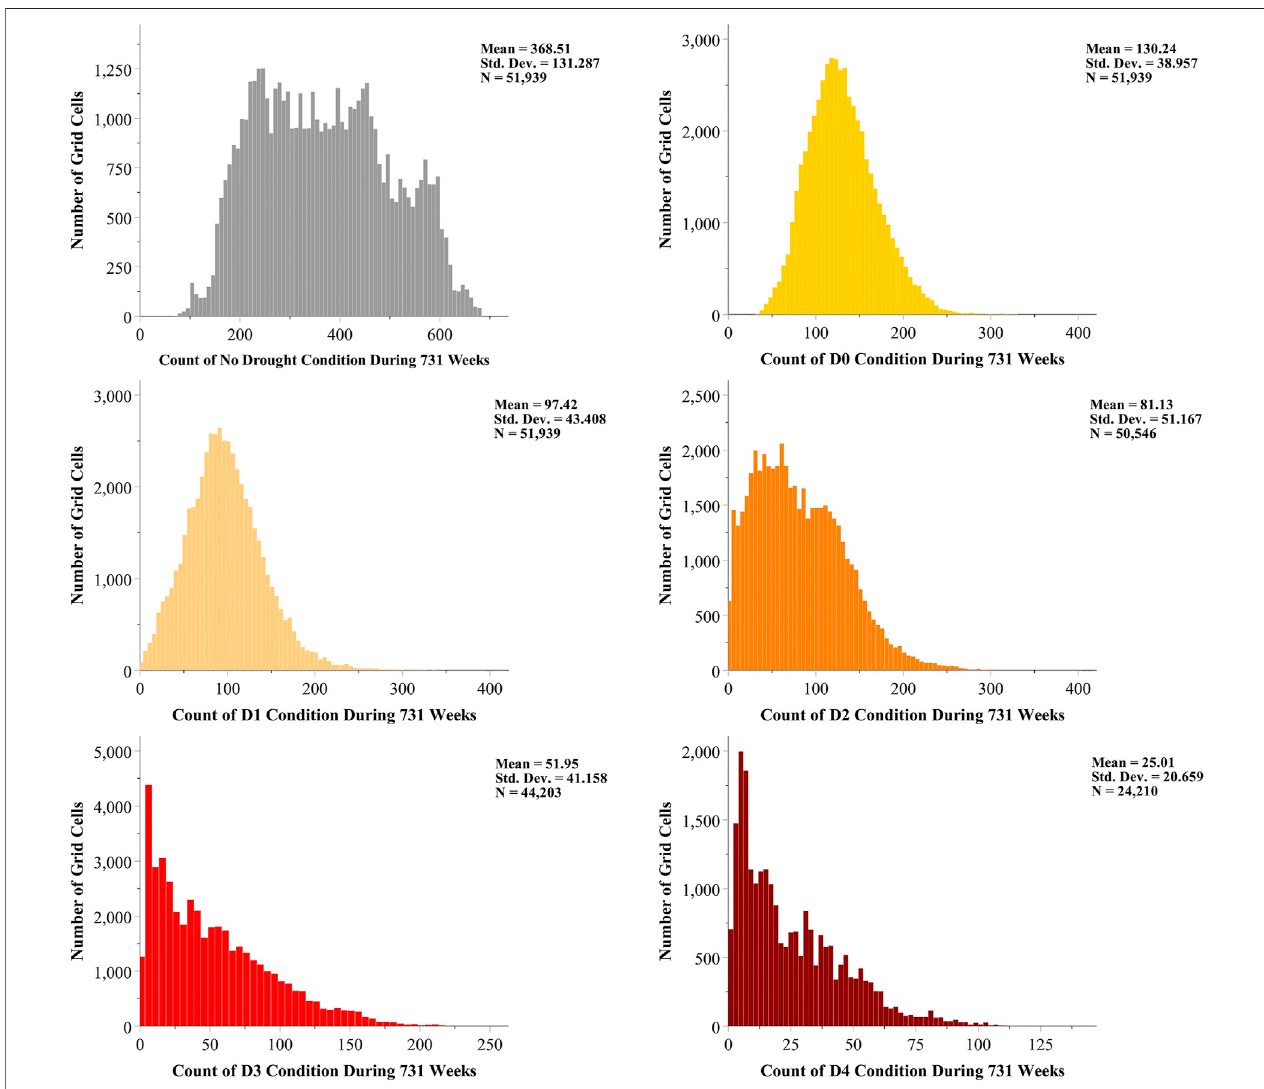
FIGURE 3 | Histograms of the USDM drought categories counts across the domain in 14 years.